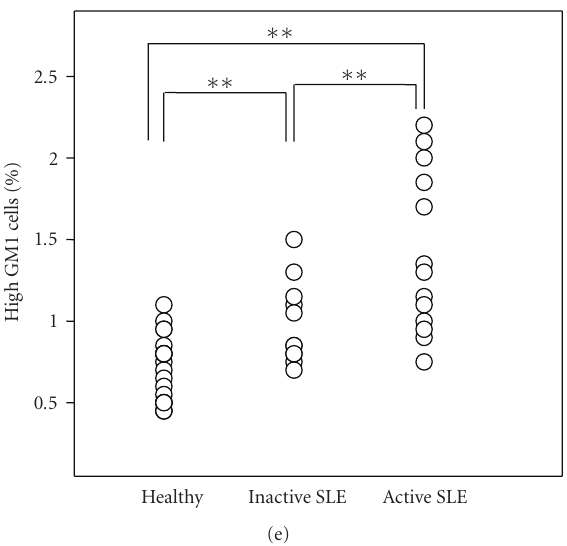
Figure 2: Lipid raft/GM1 expression on CD4+ T cells (a) and CD8+ T cells (b). SLE patients were divided into subgroups; active SLE group ( n = 21) versus inactive SLE group ( n = 23) according to SLEDAI scores, and high IgG group ( n = 24) versus normal IgG group ( n = 20) according to serum IgG level. ∗ Statistically significant di ff erences compared to the healthy ( ∗ P < . 05, ∗∗ P < . 01). #Statistically significant di ff erences between subgroup with high IgG and normal IgG. ( P < . 01) (Two-tailed unpaired Student’s t -test). (c) Percentage of CD4-positive T cells among healthy controls ( n = 23), inactive ( n = 11) and active SLE patients ( n = 13) were 46.9+2.17, 42.2+3.04 and 38.8+2.64, respectively. (d) GM1 expression on CD45RO+/CD4+ memory T cells by triple staining. Cells were first gated by CD4-APC, then analyzed with PE-CD45RO antibody and FITC-GM1. Cells with more than 10 in MFI of GM1 were determined as high GM1 cells. (e) Percent of high GM1-expessing CD45RO+/CD4+ memory T cells among normal controls, inactive and active SLE patients (0 . 69 ± 0 . 03, 1 . 00 ± 0 . 07, 1 . 35 ± 0 . 12, resp . ) . ∗∗ P < . 01